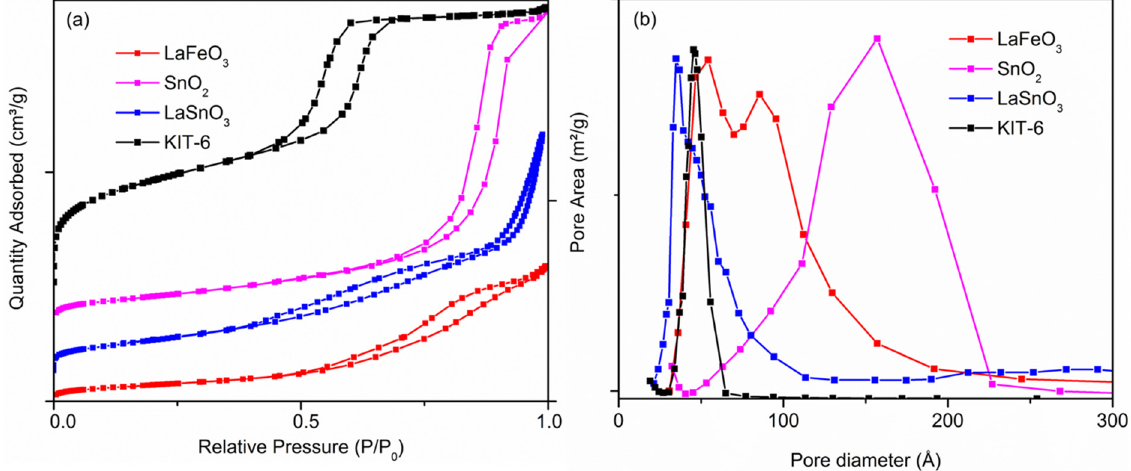
Figure 2. Nitrogen sorption isotherms for the synthesized catalyst materials ( a ) and their corresponding pore size distributions ( b ). The LaSnO 3 isotherm was vertically translated by 214.7cm 3 /g and that for KIT-6 by − 3.6 cm 3 /g. Table 1. Summary of nitrogen sorption measurements of the synthesized catalysts and comparison with the